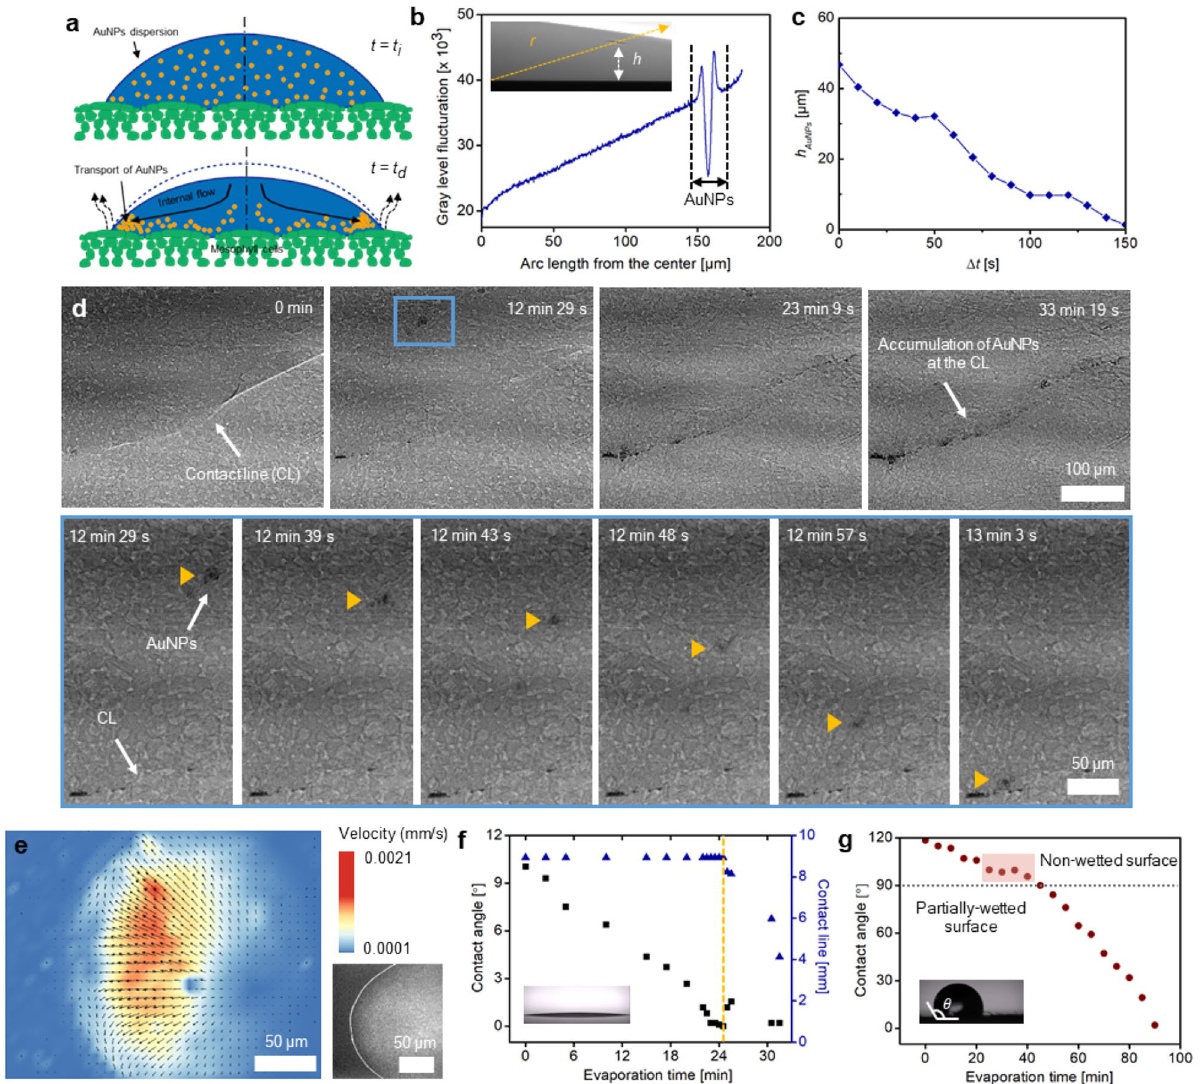
Figure 2. Transport of AuNPs by the convective internal flow in a sessile drop. ( a ) Schematics showing the dynamic behaviors of AuNPs moving toward the contact lines (CL) of a drop on the leaf surface by evaporation- driven internal flow. At the initial time ( t = t i ), AuNPs are uniformly distributed in the sessile drop. As the drop evaporates, AuNPs are translocated to the regions near the leaf surface. ( b , c ) Dynamical variations in AuNPs when a drop evaporates on a glass substrate. ( b ) Gray level fluctuations indicating the light intensity profile show the position of AuNP clusters along a yellow line. Inset is a contrast-enhanced X-ray image showing the side view of the drop. ( c ) Temporal variation in the height of AuNP clusters ( h AuNPs ). The gradual decrease in h AuNPs shows the transport of AuNPs toward the glass surface. ( d ) Sequential X-ray images show the top view of AuNP clusters gathering toward the CL region due to evaporation-driven internal flow. Accordingly, stomata positioned near the CL are easily infiltrated by wicking of AuNP suspension. Magnified images in blue box show temporal variations in the position of AuNP clusters. ( e ) Velocity field of the flow in the sessile drop deposited on a glass substrate, measured by applying a PIV technique from the top view. ( f , g ) Temporal variations in contact angle (CA) of a sessile drop on ( f ) a flat glass substrate and ( g ) the abaxial surface of P. frutescens ( n = 1). Insets show the side view of a 2 μl sessile drop and θ indicates